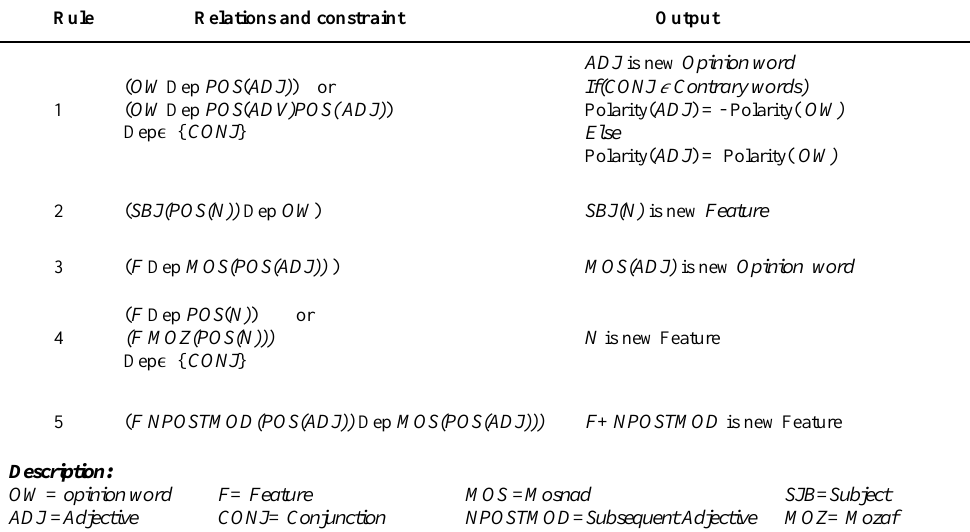
Table 1. Rules of dependency